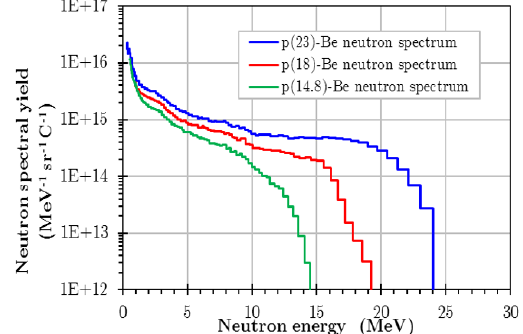
Figure 1. The p + Be neutron spectra measured by M.A. Lone using time-of-flight technique.